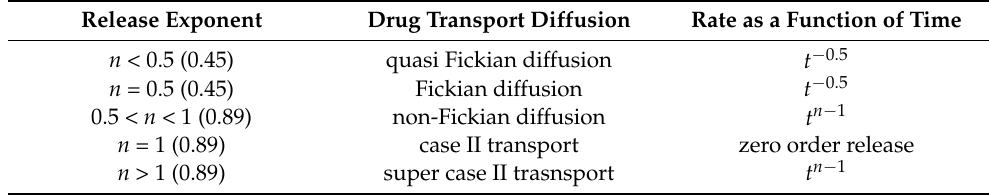
Table 2. Release mechanism with variation of “ n ” values